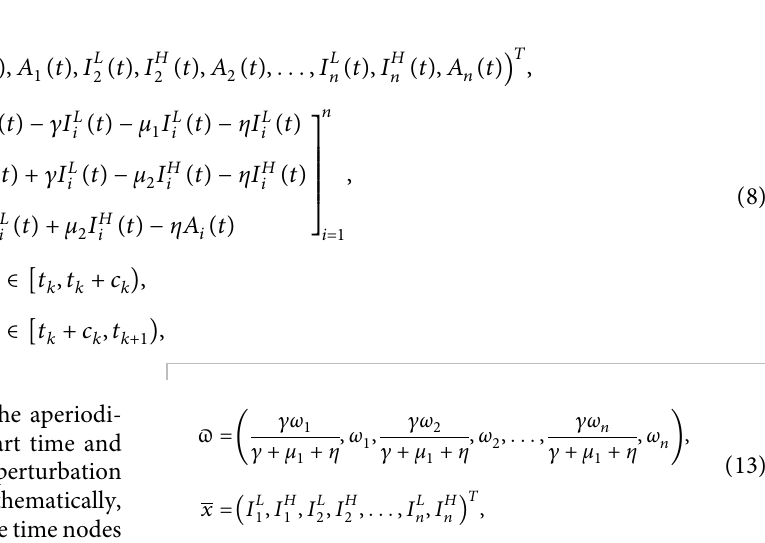
Figure 2: The sketch of aperiodically intermittent control